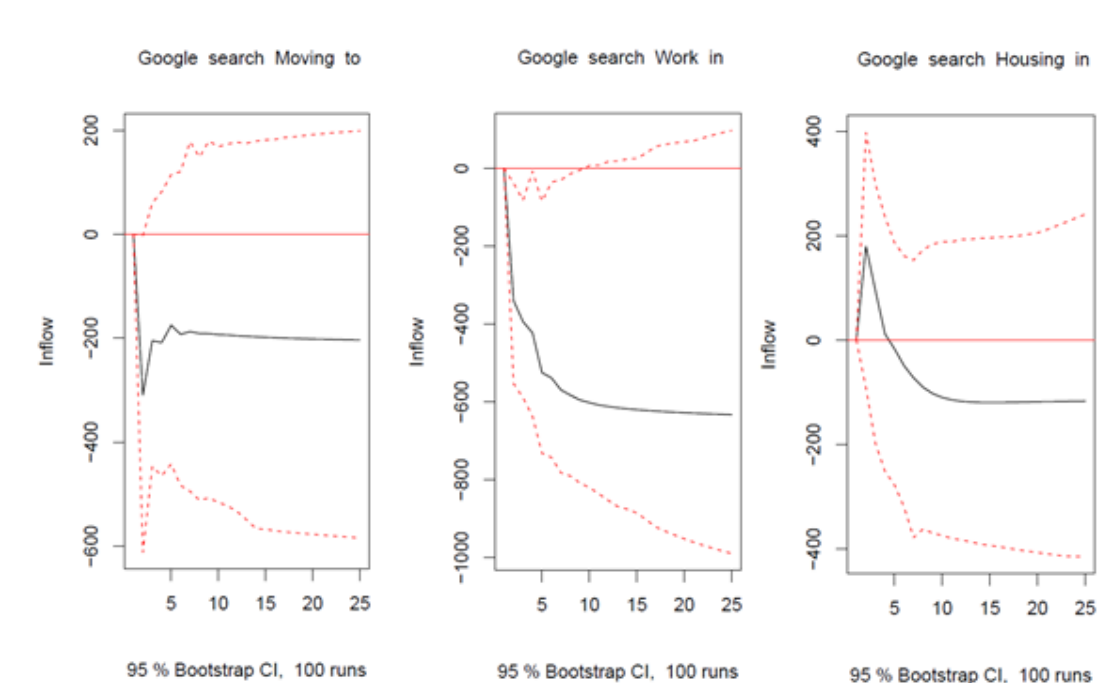
Figure A4. VECM (1) with centered seasonal dummies: orthogonalized impulse responses from a scheme 24 months.